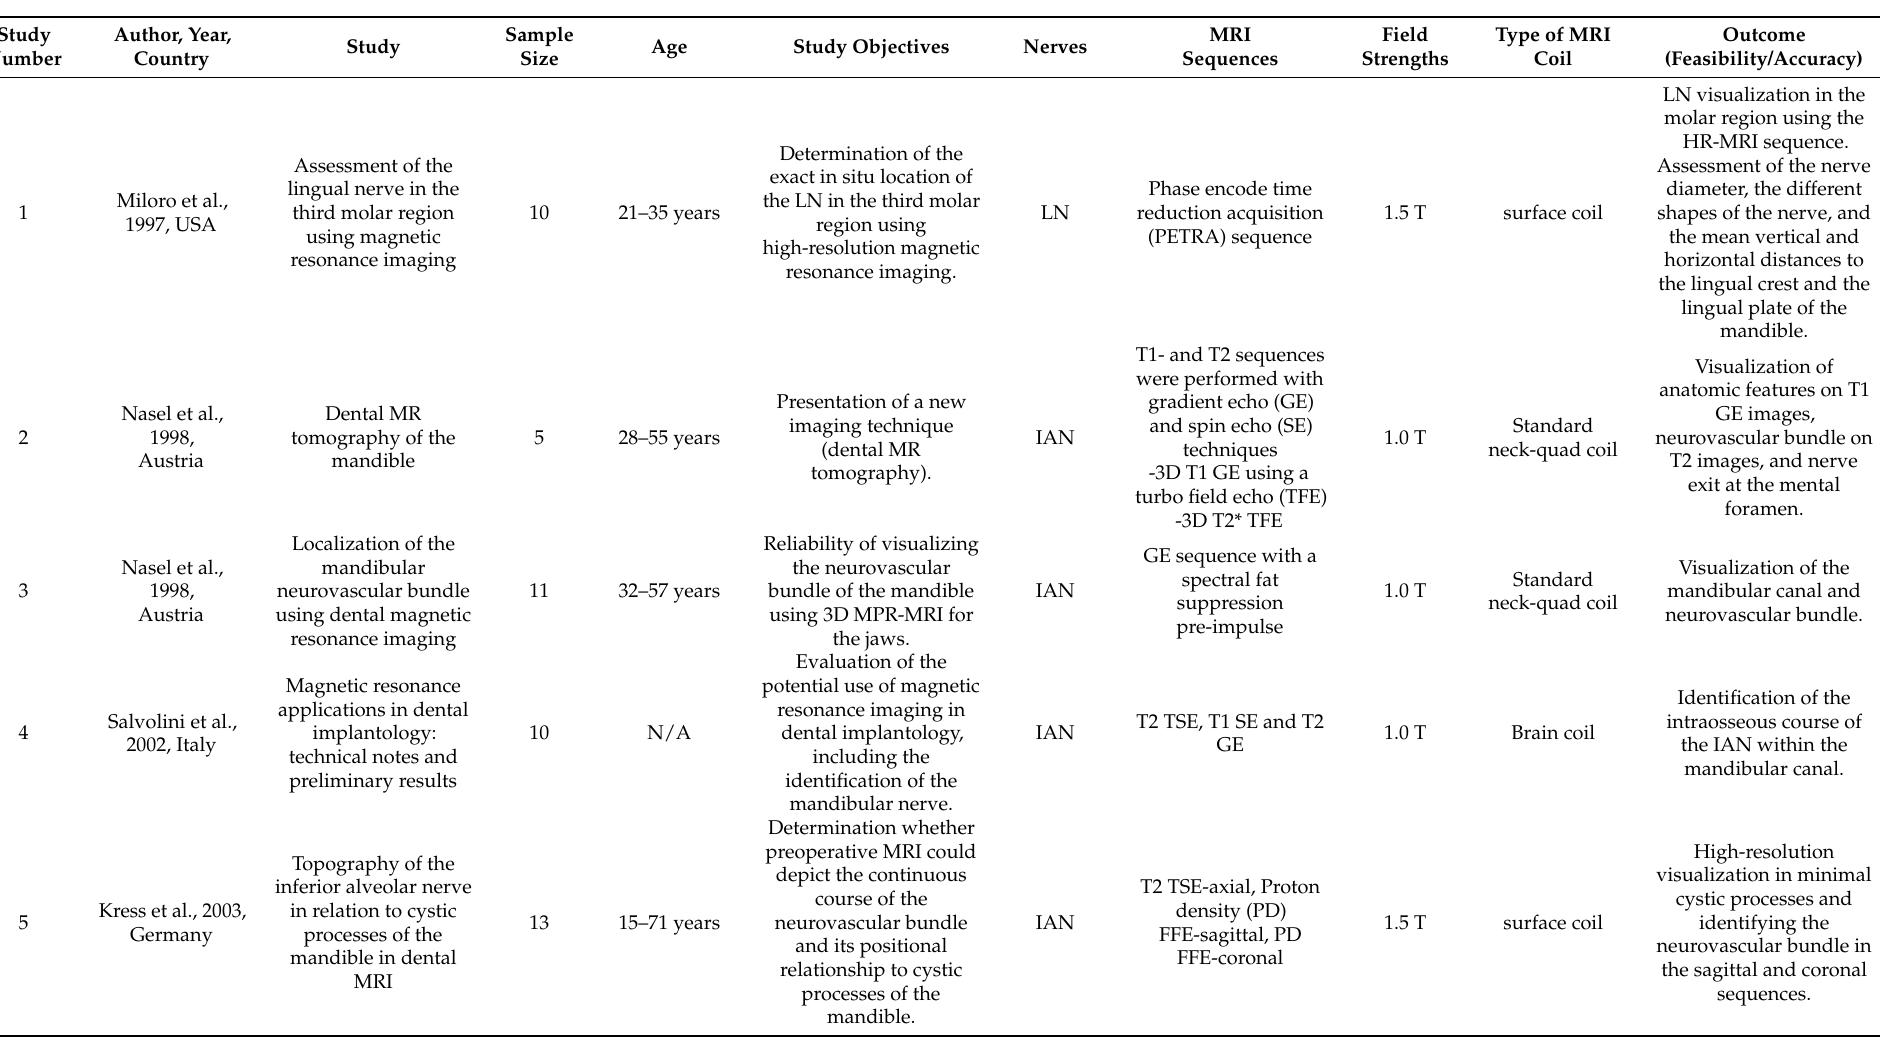
Table 2. Characteristics of included